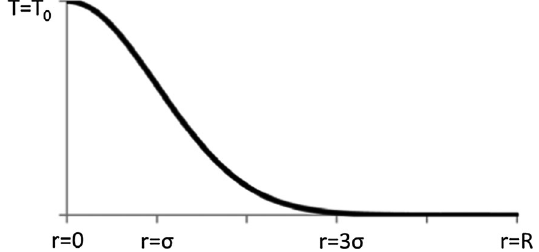
FIG. 3. Gaussian initial condition as used in the method presented